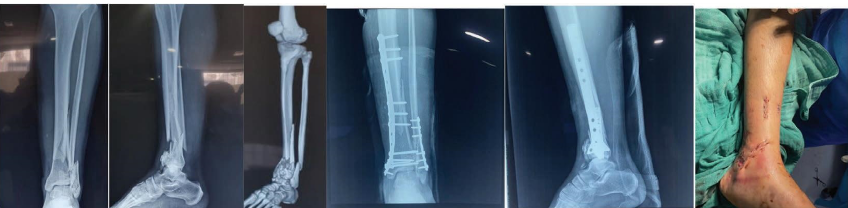
Figure 2: Pre- and postoperative radiographic and clinic check-up of a 42-year-old patient operated on for a 43-C3 fracture using a minimally invasive approach. Table 1: Tscherne classifcation for soft tissue injuries. Tscherne grade